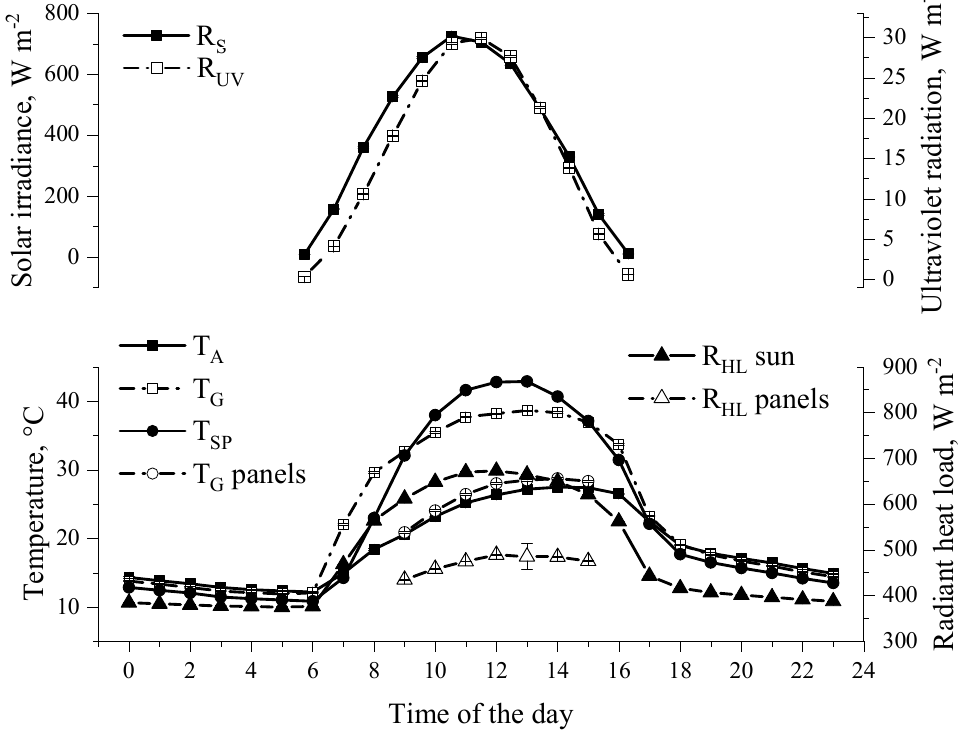
Figure 2. Least square means ( ± SEM) of the meteorological variables during thermal evaluations of the shade of solar panels. T SP = surface temperature of panels; T Gpanels = black globe temperature in shade projected by solar panels; TG = black globe temperature in full sun; R HL panels = Radiant heat load in shade of panels; R HL sun = Radiant heat load in full sun.